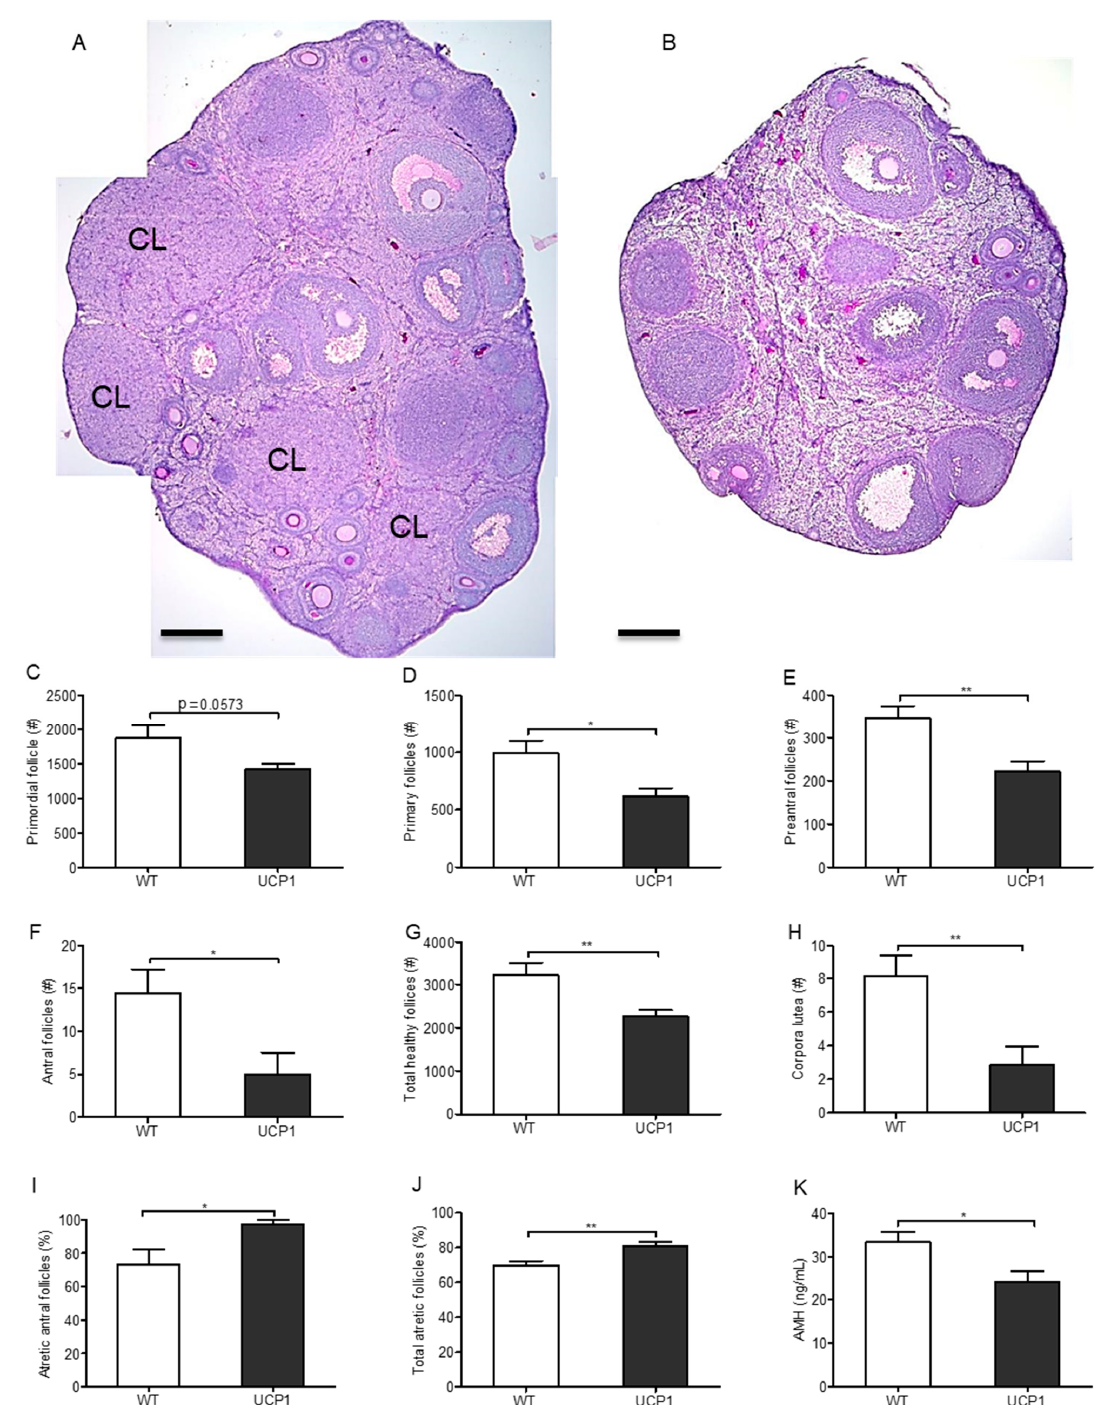
Figure 4. Ovarian follicular development of UCP1-TG (UCP1) and WT mice. Representative images of the gross ovarian morphology of WT ( A ) and UCP1-TG ( B ) mice. Numbers of primordial follicles ( C ), primary follicles ( D ), preantral follicles ( E ), antral follicles ( F ), total number of healthy follicles ( G ), and corpora lutea ( H ) per ovary. Percentage of atretic cleaved caspase 3 (cCASP3) positive antral follicles of WT and UCP1-TG mice ( I ) and percentage of total atretic follicles (of (pre)antral and unknown origin) ( J ). Plasma anti-Müllerian hormone (AMH) levels (ng/mL) (K). #, numbers; %, percentage; Values represent means +/ − SEM 686 ( n = 8, except for cCASP3, n = 4); ( C – K ): Student’s t-test * p < 0.05; **, p < 0.01. CL, corpus luteum, scale bar represents 200 µ